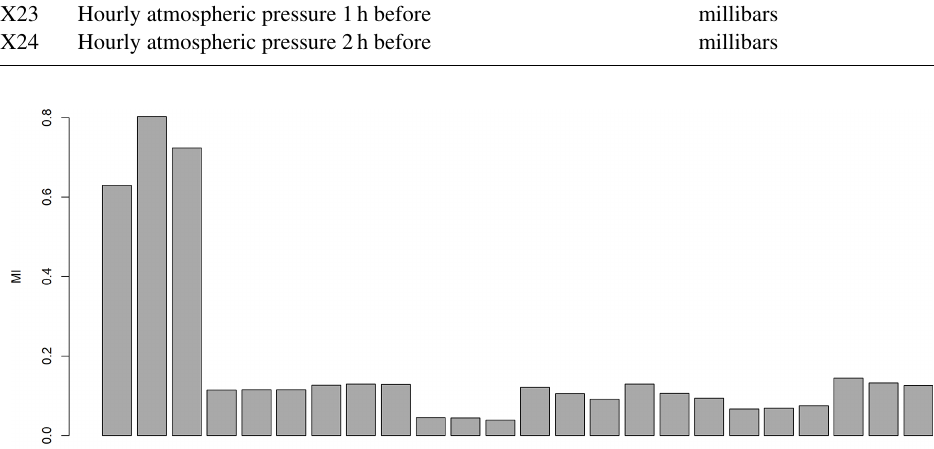
Figure 7. Mutual information (MI) of all predictor variables to hourly water level dynamics in 3 months of observational